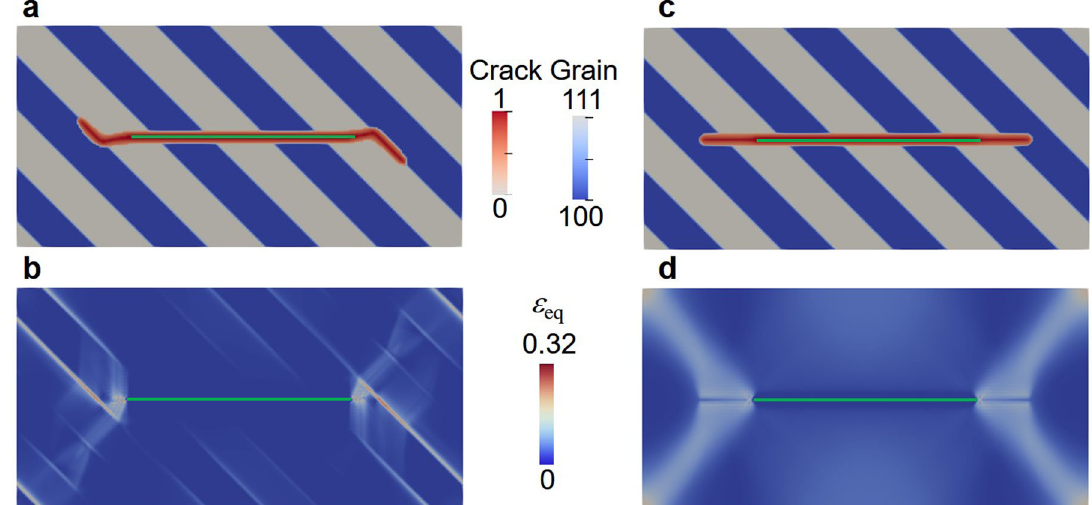
Fig. 4 Crack growth in FCC bicrystals. a , b Distribution of grains, cracks, and equivalent plastic strain considering crystal plasticity within each grain. c , d Distribution of grains, cracks, and equivalent plastic strain assuming J 2 plasticity within each grain. The green lines indicate the position of the initial crack.